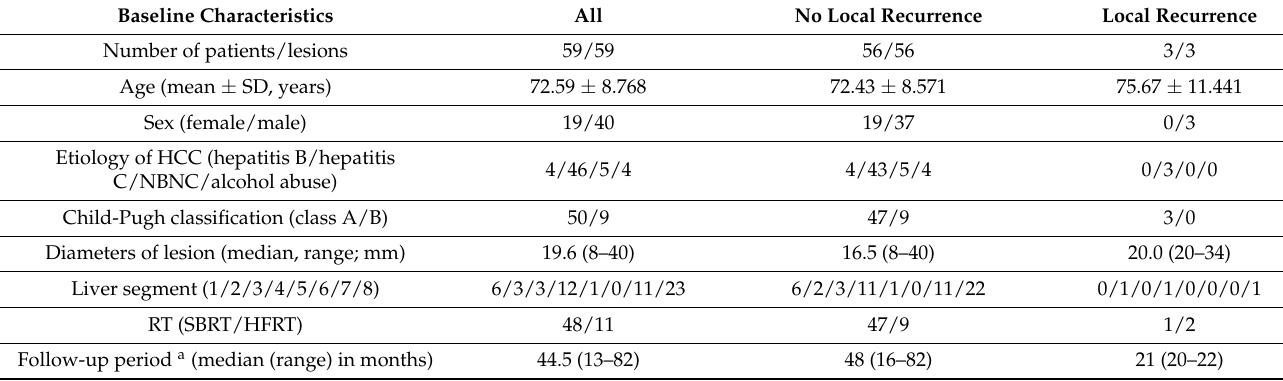
Table 1. Clinical characteristics of enrolled